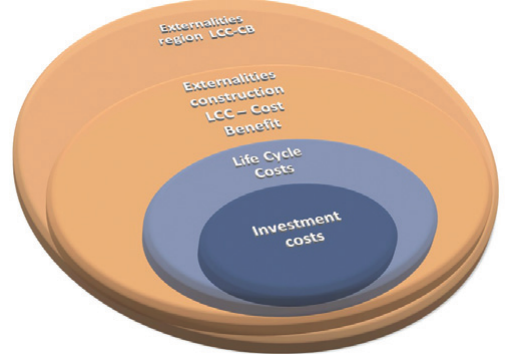
Fig. 1. Structure of Life Cycle Costs